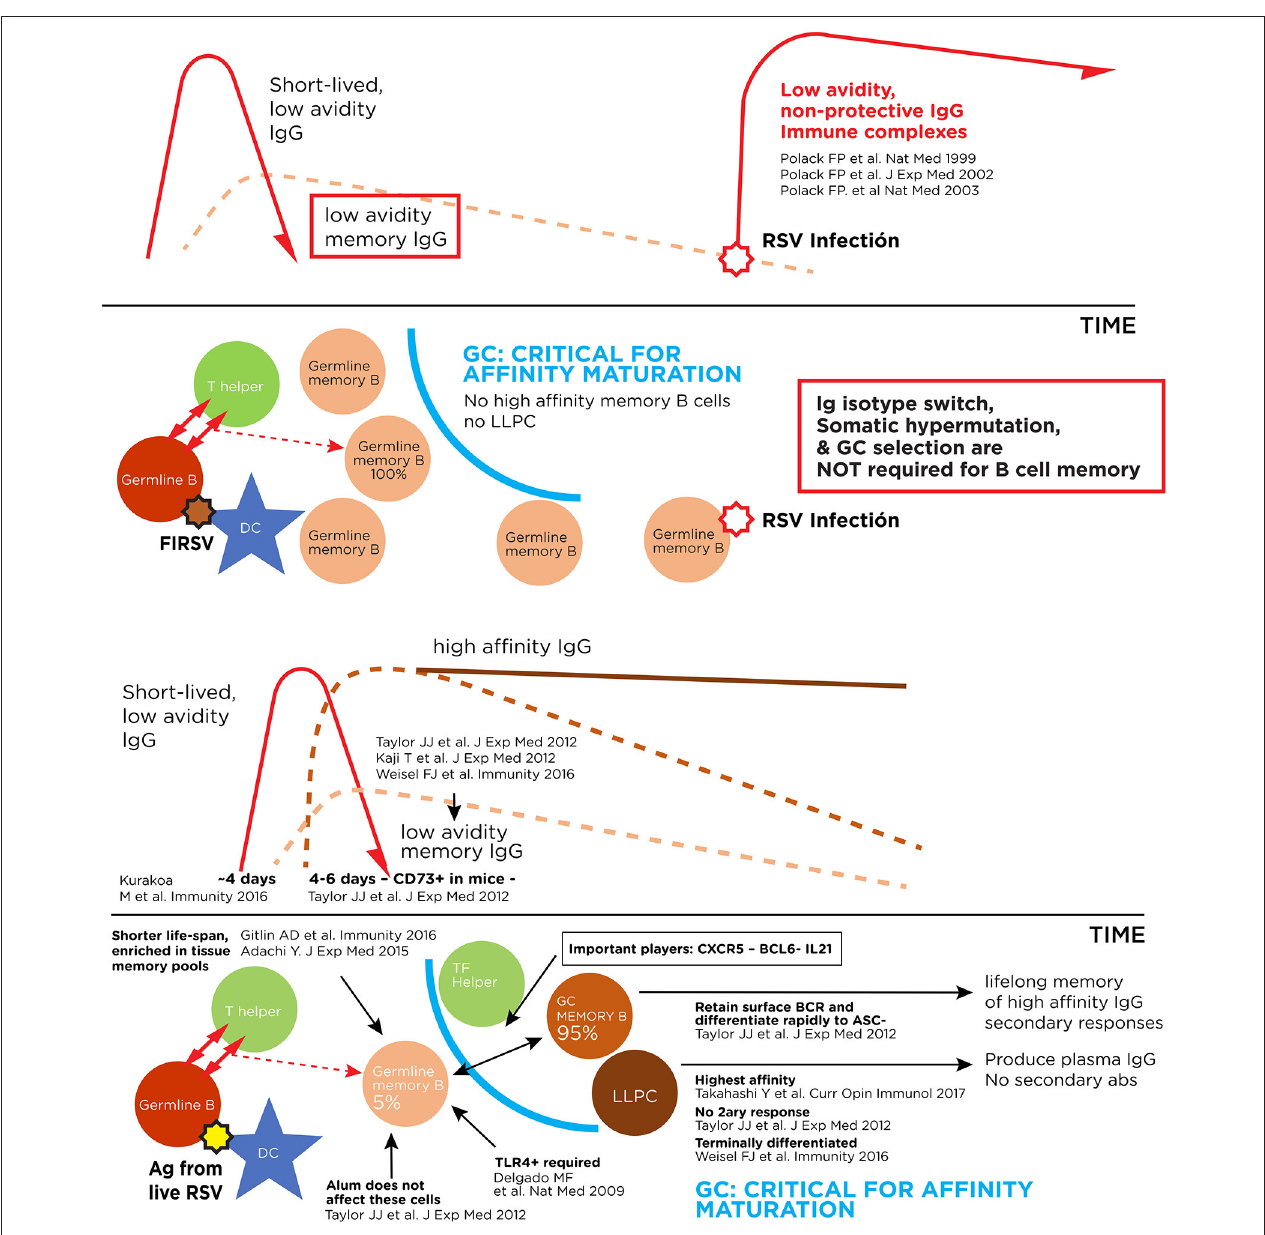
FIGURE 1 | Pathogenic and protective antibody responses against RSV. Upper panel: Immune complex formation with antibodies of low affinity for the virus. Lower panel: Antibody response to live RSV infection with production of high affinity long-lived memory B cells and long-lived plasma cells (LLPC).